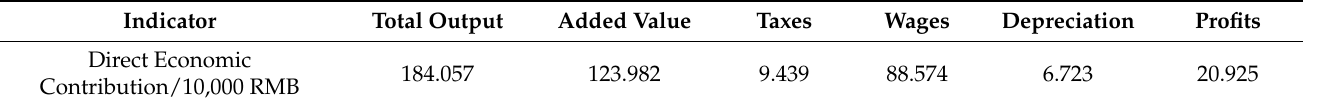
Table 1. Direct economic contribution of Xiamen Port to the city in 2017 .